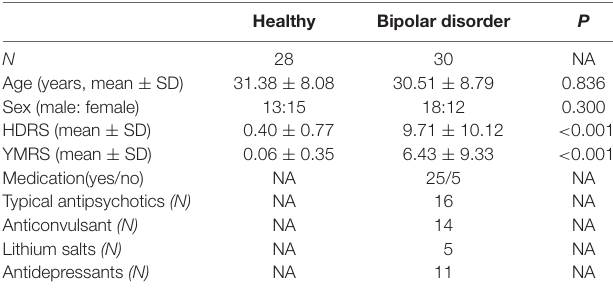
TABLE 1 | Demographic and clinical data of